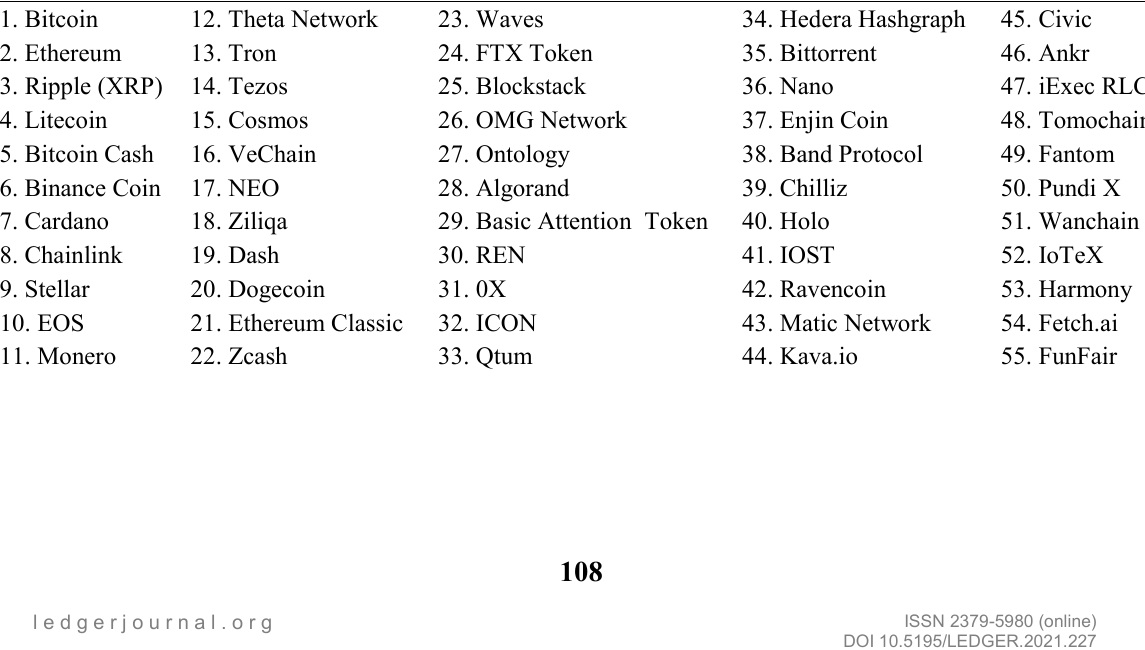
Table 1. List of cryptocurrencies included in this study (ranked by market capitalization as of 1 January 2021). Stablecoins are